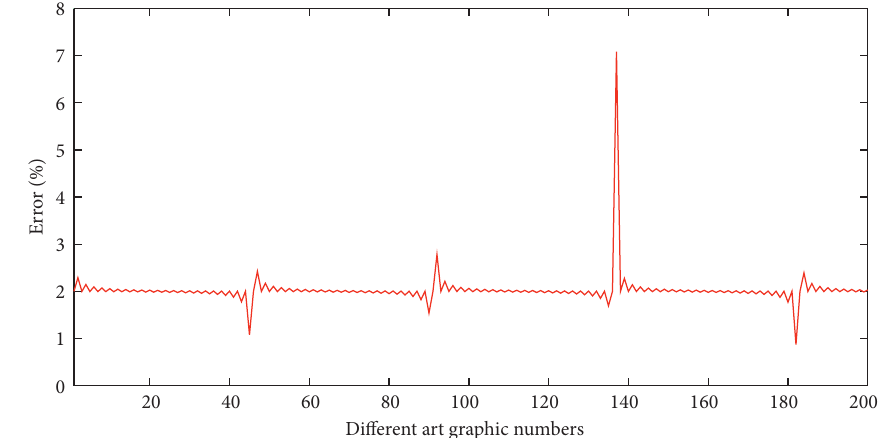
Figure 4: Calculation results of the initial values of different artistic